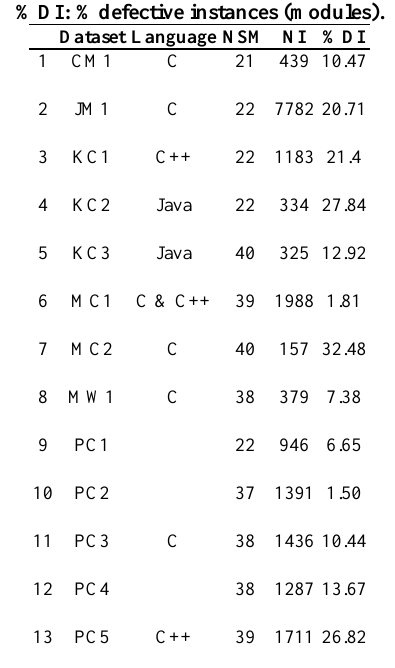
Table 1. NASA PROMISE datasets. Legends: NSM: #software metrics, NI: